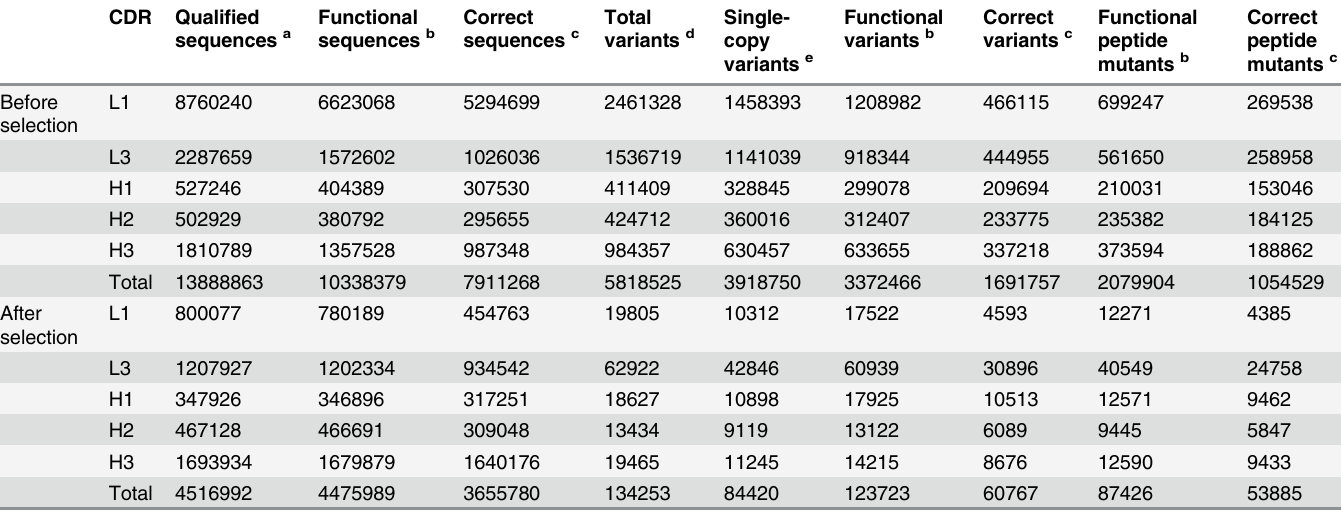
Table 2. Summary of the NGS data in the unselected and selected libraries.